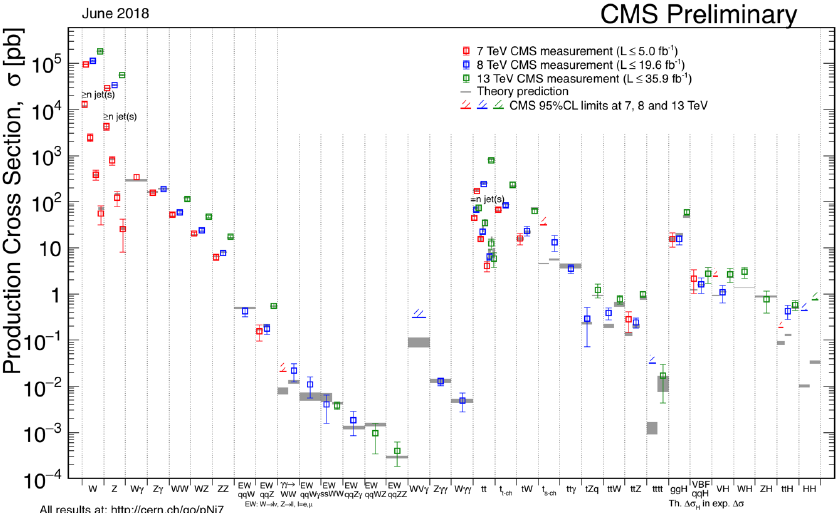
Figure 5. Summary of the cross-section measurements of SM processes